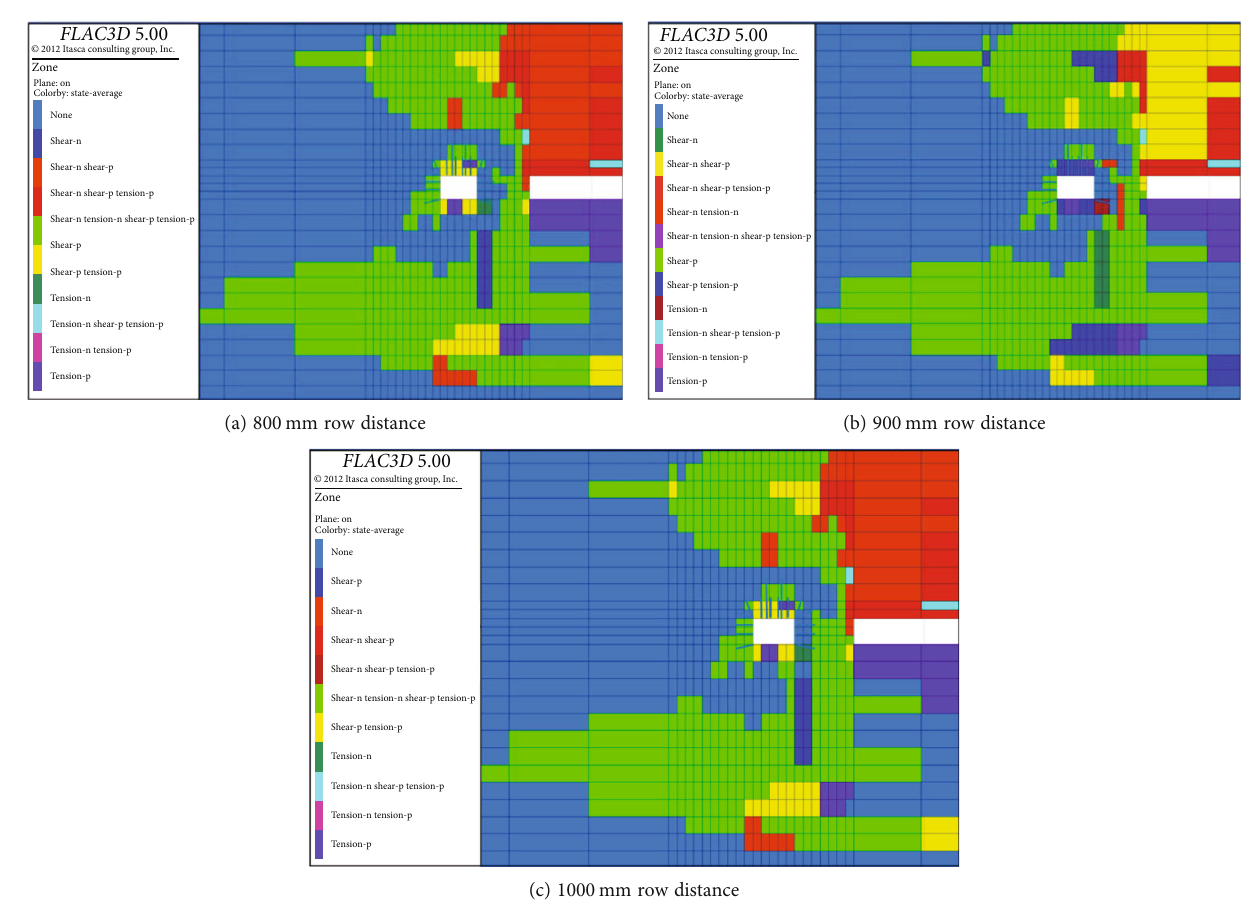
Figure 12: Plastic zone distribution of 7 m width coal pillars and surrounding rock of roadway along goaf under the condition of di ff erent bolt (cable) support row